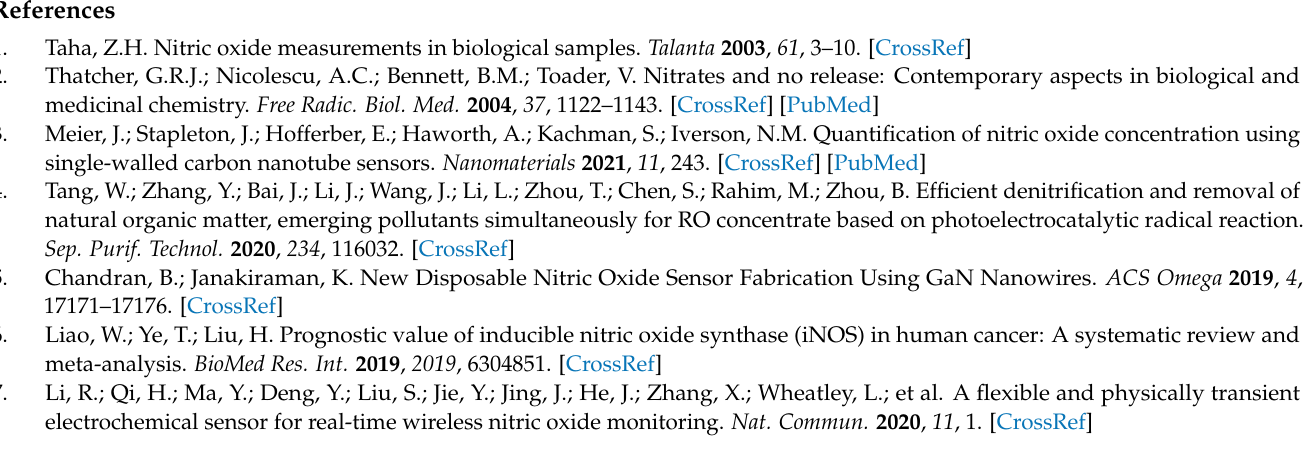
Table S1: BPND optimization studies parameters, Table S2: Analytical data for SPCE/Cu-BPND sensor response for DEA NONOate detection, Table S3: Analytical data for SPCE/Ni-BPND sensor response for DEA NONOate detection, Scheme S1: Synthesis protocol and characterization